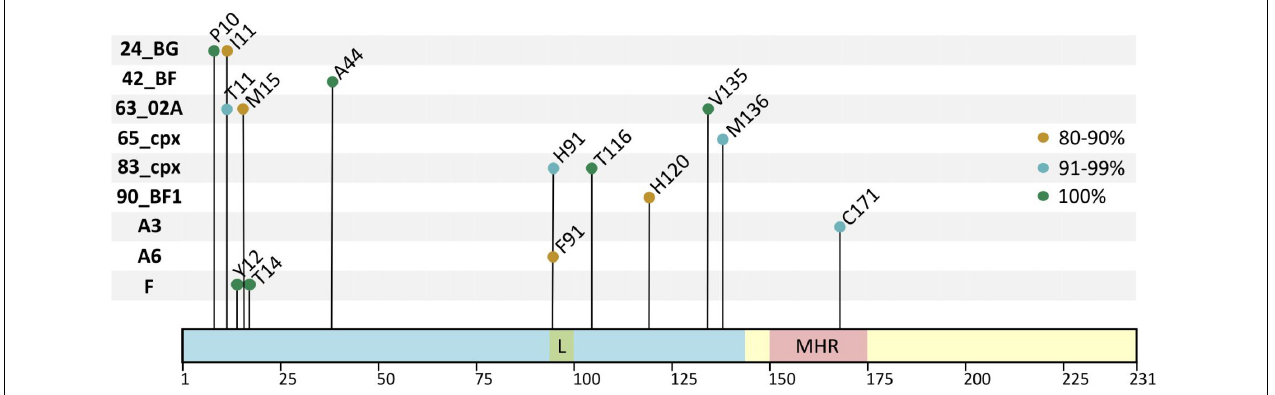
FIGURE 5 | Single V-markers across HIV-1 group M variants. X -axis, p24 positions and relevant domains; Y -axis, HIV-1 variants carrying single V-markers. In light blue, N-terminal domain, including the Cyp A-binding loop (L) in green. In light yellow, C-terminal domain, including the major homology region (MHR) in red; the conservation percentage of each V-marker is represented in the figure with colored circles (in green, 100%; in blue, 91–99%; in orange, 80–90%). In HXB2 HIV-1 reference sequence the residues present in each site were: M10, V11, H12, A14, I15, S44, I91, G116, N120, I135, L136, and T171. In group M consensus the same residues were present except for